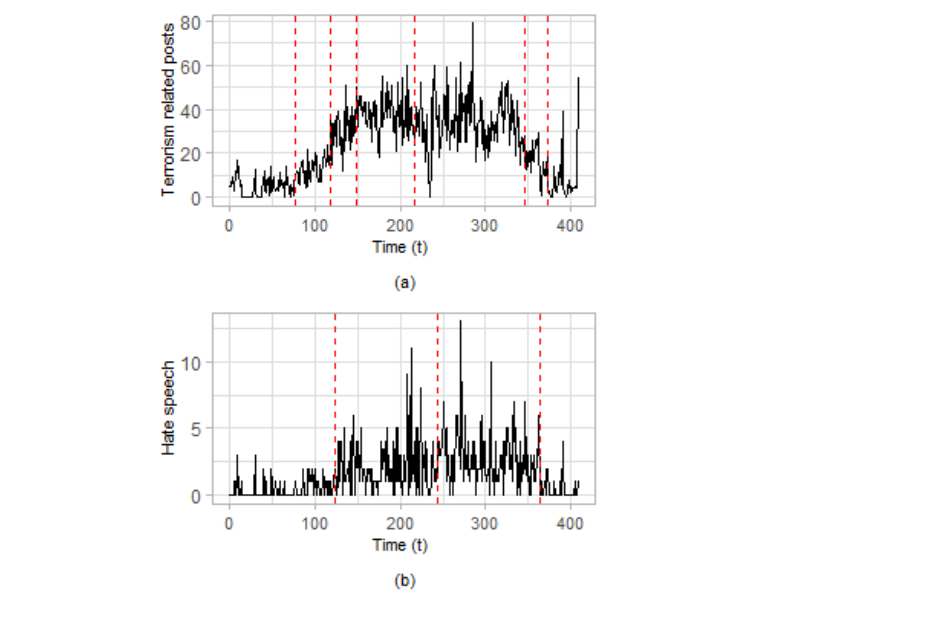
Figure 6. ( a ) Application of CPD on the time series of terrorism-related posts. ( b ) Application of CPD on the time series of posts containing hate speech; the time locations of the estimated change points are depicted as red vertical lines. Table 3. Estimated change points for the time series with terrorism-related posts along with the corresponding significance values.